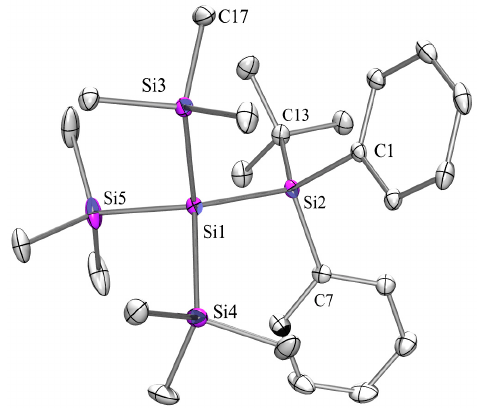
Figure 21. Crystal structure of 23 . Thermal ellipsoids are represented at the 30% level and hydrogen atoms have been omitted for clarity (bond lengths in Å, angles in deg). Si(1)-Si(3) 2.3600(10), Si(1)-Si(5) 2.3654(10), Si(1)-Si(4) 2.3727(10), Si(1)-Si(2) 2.3827(10), Si(3)-Si(1)-Si(5) 107.02(4), Si(3)-Si(1)-Si(4) 105.31(4), Si(5)-Si(1)-Si(4) 103.48(4), Si(3)-Si(1)-Si(2) 108.01(3), Si(5)-Si(1)-Si(2) 119.85(3), Si(4)-Si(1)-Si(2) 112.18(3).